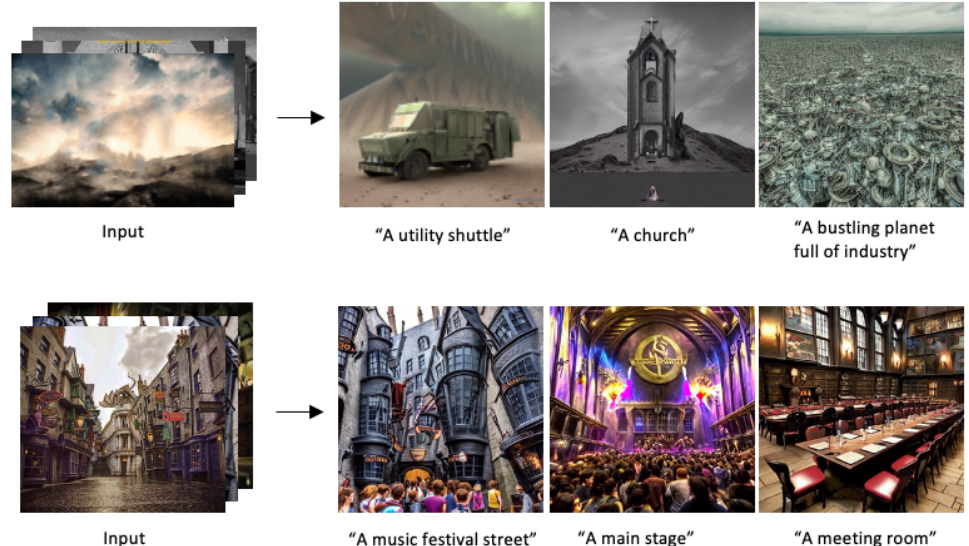
Figure 6. Example of the story visualization